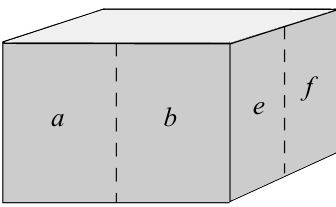
Figure 1. Firefly